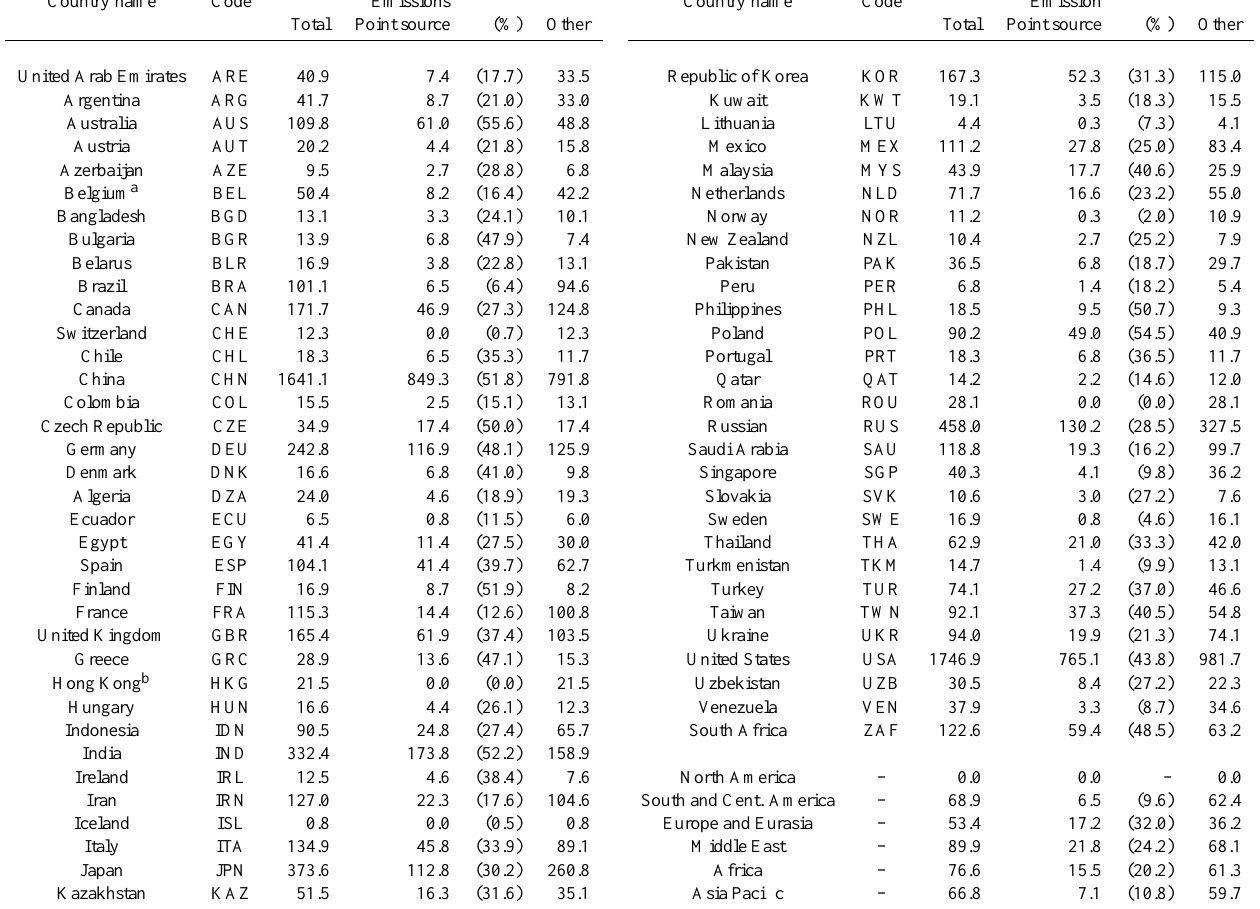
Table 1. Summary of the national and regional annual emission estimates for the year 2006. “Code” in the second column refers to the standard country or area codes defined by the Statistical Division of the United Nations (http://unstats.un.org/unsd/methods/m49/m49.htm). National and regional emissions are shown in the national total (“total” in the third column), point source emission accompanied by the percentage of the national total (“point source” in the fourth column), and emissions from other sources (“other” in the last column). Values are reported in units of Megatonne carbon year − 1 . ( a : Belgium includes Luxemburg. b : Administrative